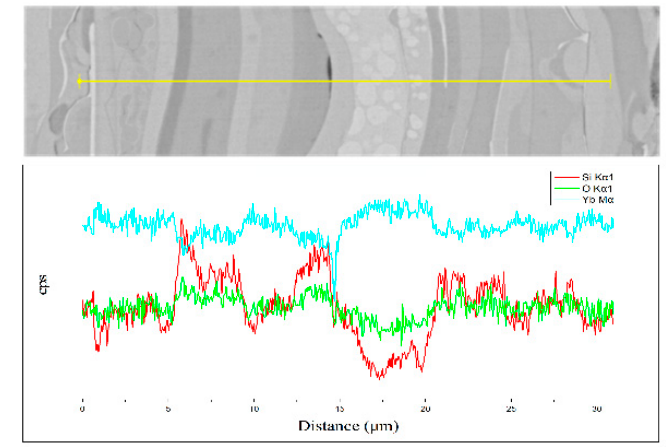
Figure 6. EDS line scan of the as-sprayed ytterbium silicate top-coats prepared by parameter set B.